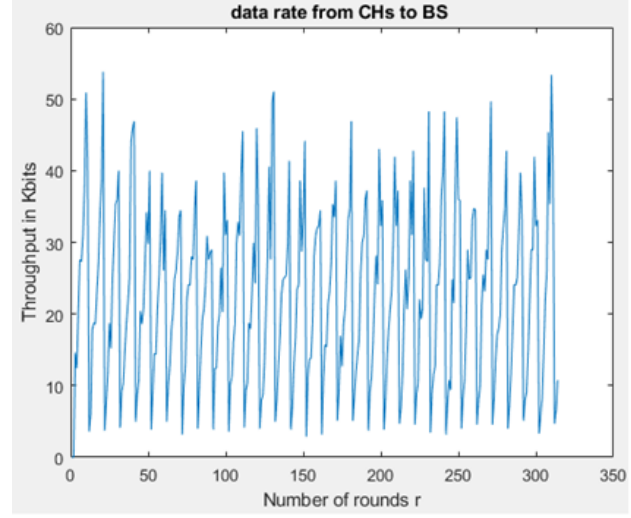
Figure 34. NB-IoT D2D attocell network throughput.